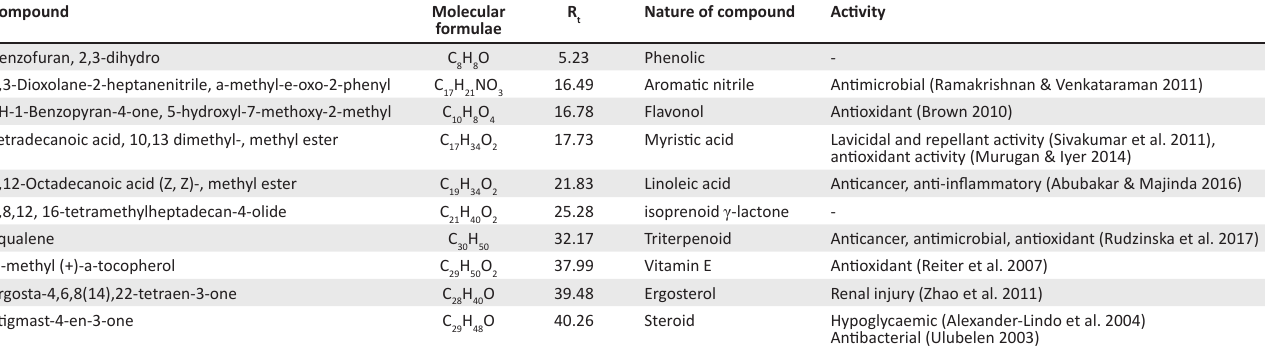
TABLE 4: Phytochemical compounds of Prunus africana identified by gas chromatography – mass spectrometer. Compound Molecular formulae